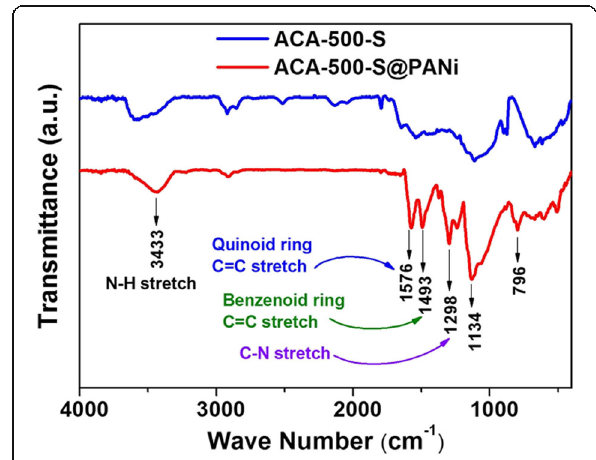
Fig. 2 FTIR spectra of ACA-500-S and ACA-500-S@PANi